Question: Briefly state, in one sentence, what is plotted here.
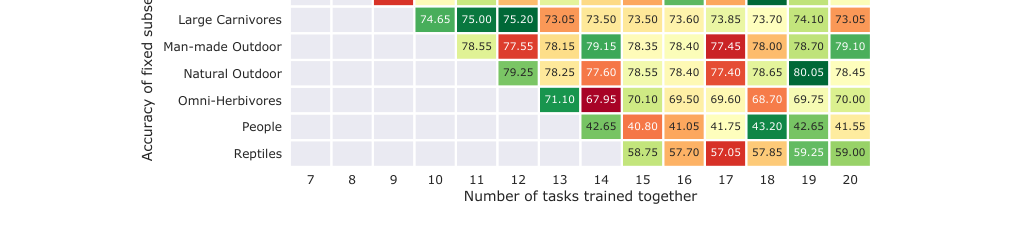
Answer: Competition between tasks in continual learning can be non-trivial. In order to demonstrate how some tasks help and some tasks hurt each other, we run a multi-task learner for a varying number of tasks (X-axis) and track the accuracy on a few tasks from CIFAR100 (each task is a superclass). Each cell represents a diﬀerent experiment, i.e, there is no continual learning being performed here. Cells are colored warm if accuracy is worse than the median accuracy of that row. For instance, multi-task training with 11 tasks is beneﬁcial for “Man-made Outdoor” but accuracy drops drastically upon introducing task #12, it improves upon introducing #14, while task #17 again leads to a drop. One may study the other rows to reach a similar conclusion: there is non-trivial competition between tasks, even in commonly used datasets. As we show, tackling this eﬀectively is the key to obtaining good performance on continual learning problems. See Appendix B.1 for a more elaborate version.